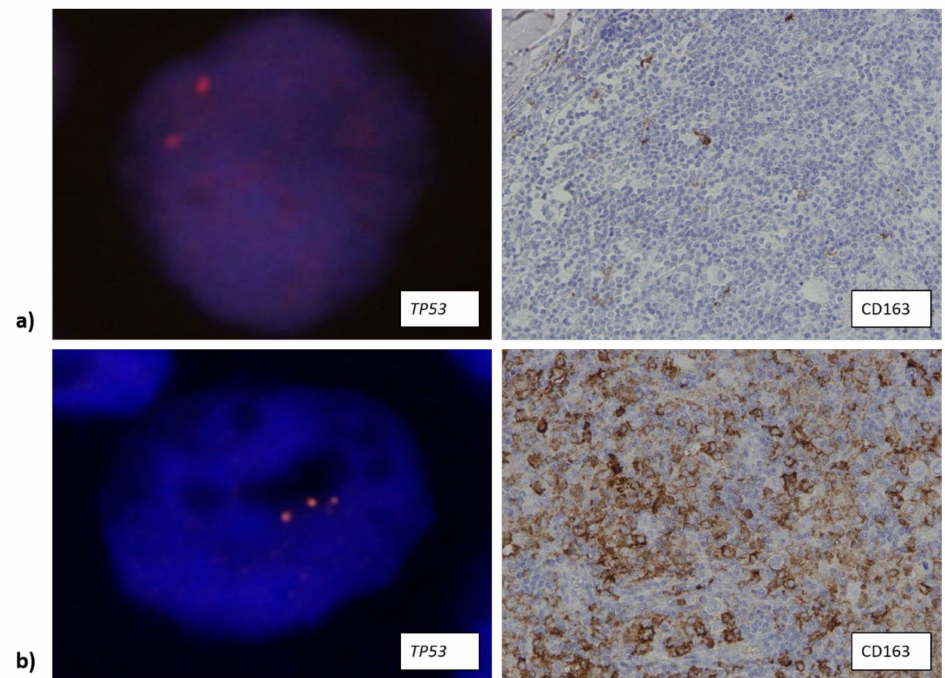
Figure 4. ( a ) Tumor samples that contained two or less copies of the TP53 gene (1000 × total magni- fication) were infiltrated with a lower number of CD163+ macrophages (400 × total magnification). ( b ) Three or more copies of the TP53 gene (1000 × total magnification) were associated with a higher number of CD163+ cells infiltrating the tumor tissue (400 × total magnification). Data about BCL6 translocation were available for 114 samples. Only 11 samples (~10%) contained this translocation, but it was more often observed in samples with either a low or high number of CD163+ cells (Figure 5a) (27.3% and 54.5%, respectively) compared to samples that contained an intermediate number of CD163+ cells (Figure 5b) ( p =